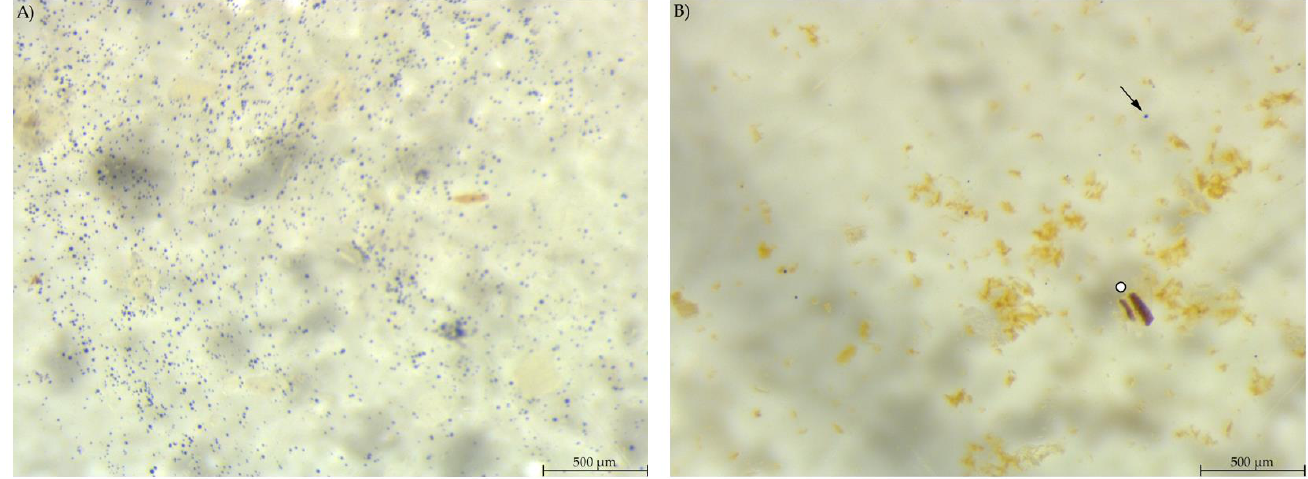
Figure 6. Samples from the anterior small intestine stained with Lugol ’ s iodine. ( A ) PEL showing a higher amount of small, round stained particles than ( B ) EXT (stereomicroscopy, 25 ×; ○ marking larger fragments of starch, ↓ marking small round particles in B).